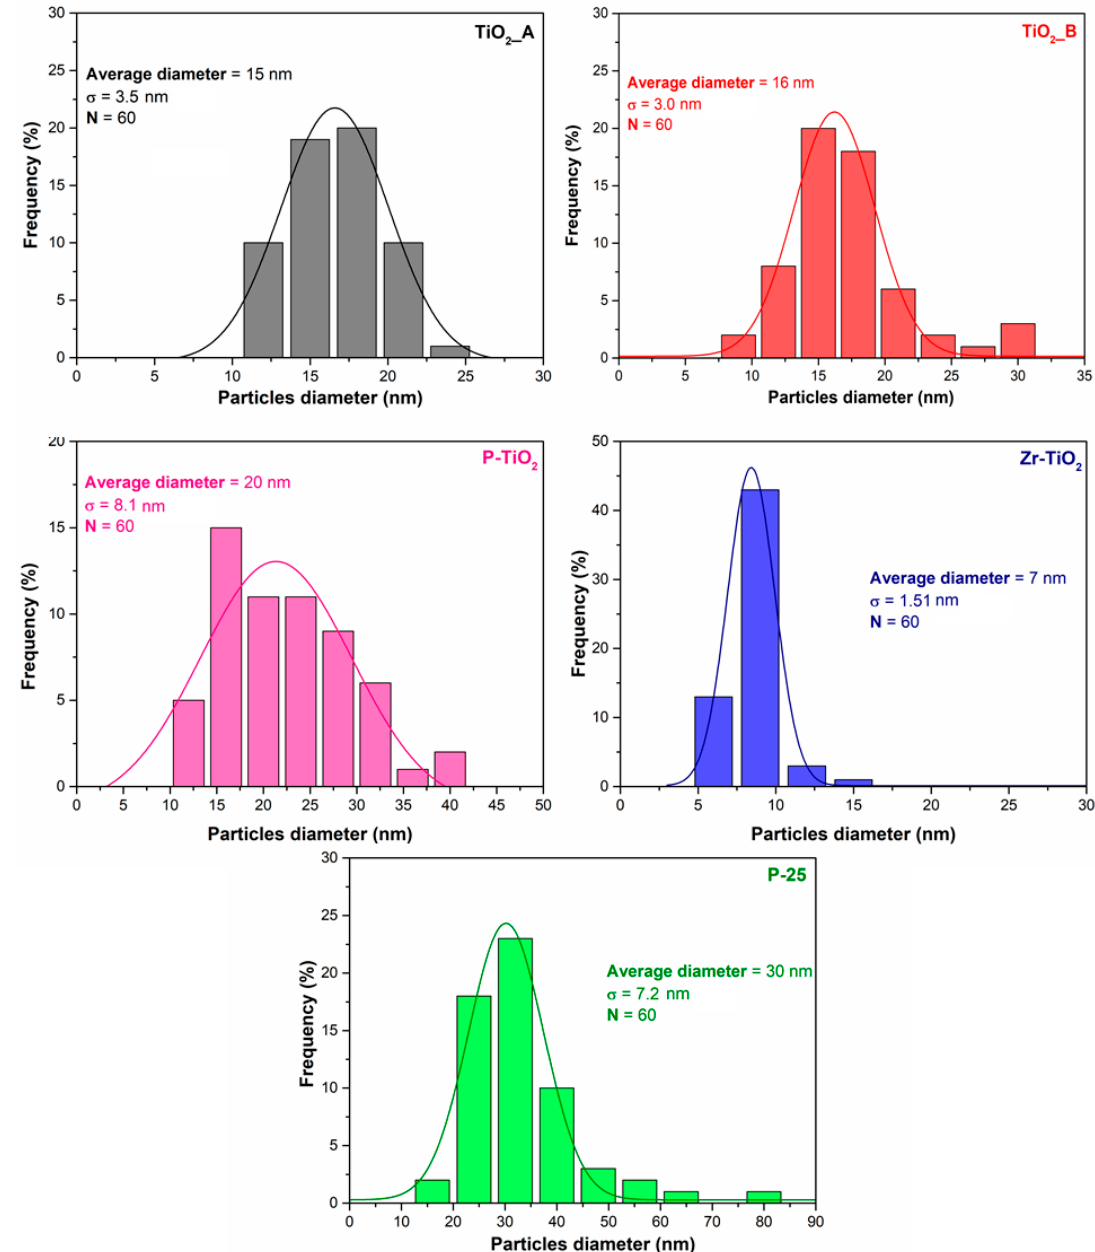
Figure 3. Particle size distribution of the samples studied.